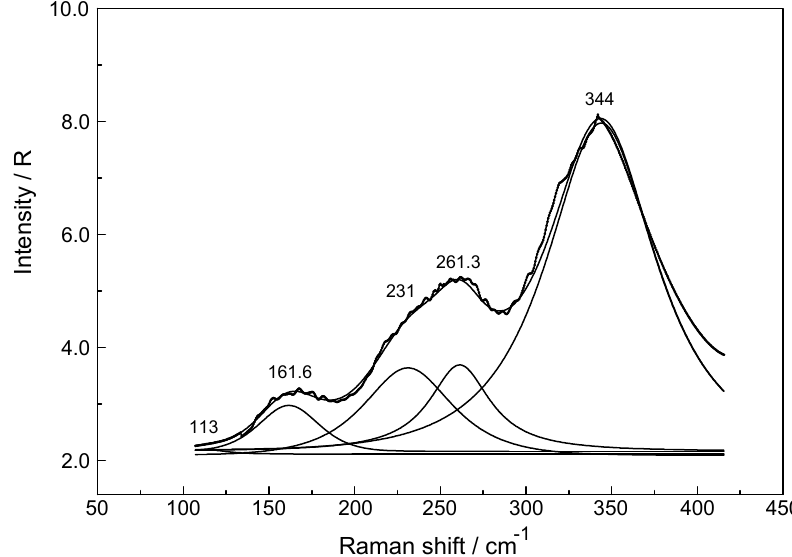
Figure 3. Anisotropic scattering profile in R-format of a 2.233 mol · L − 1 Lu(ClO 4 ) 3 (aq) solution. Given are the measured curve, the sum curve and the 5 component bands of the band fit.